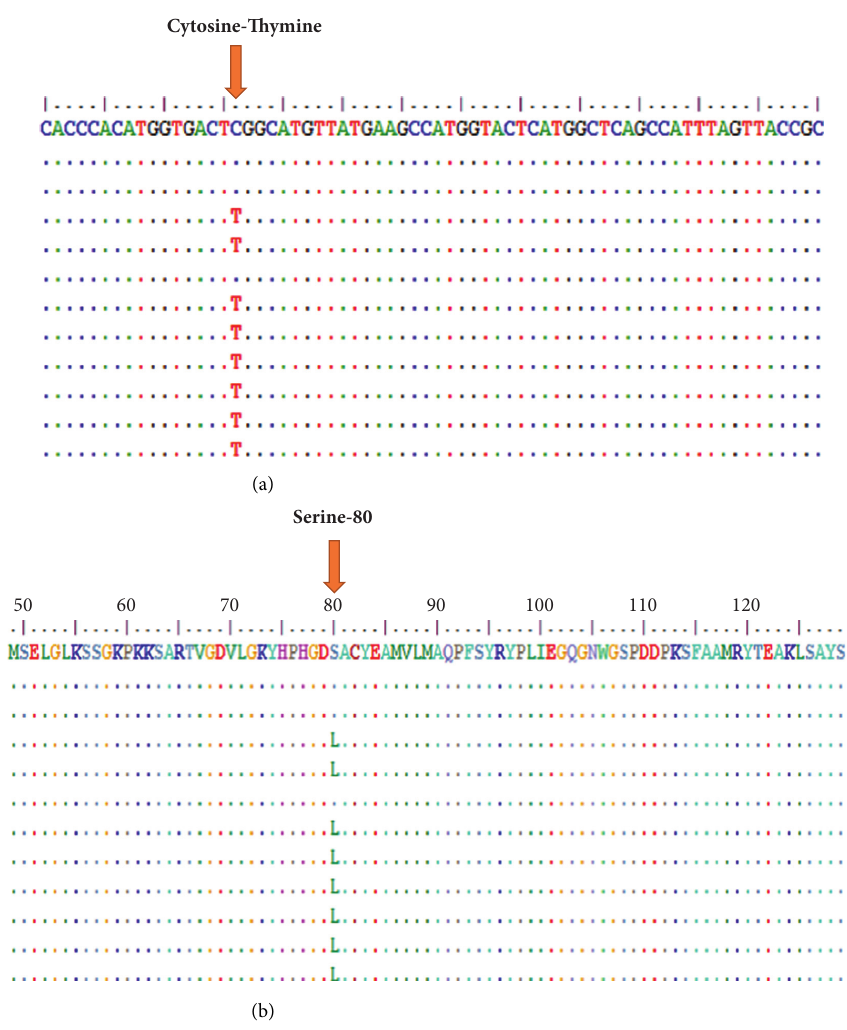
Figure 2: Sequences analysis of parC gene.